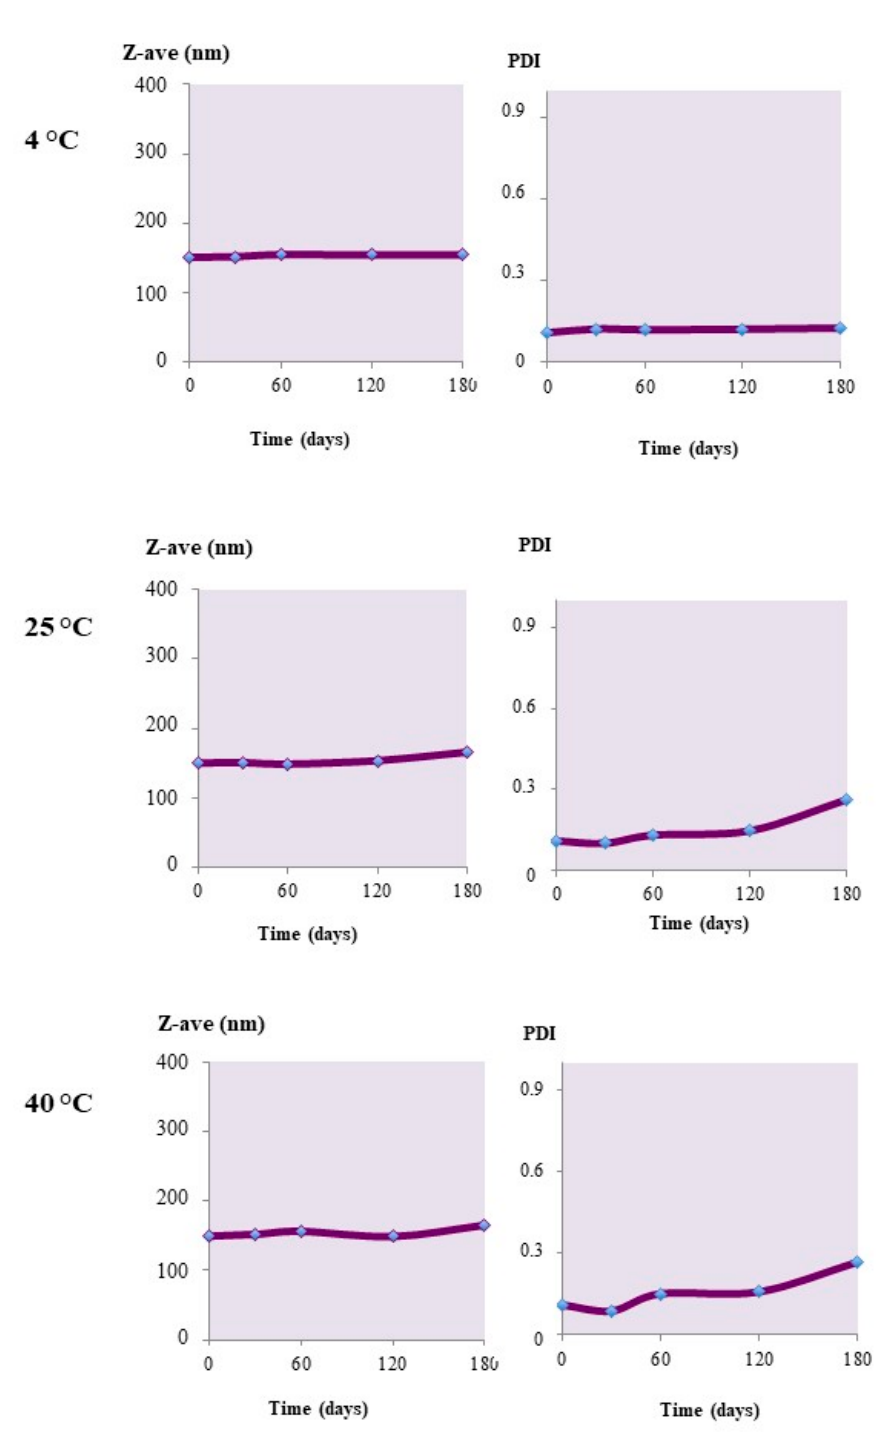
Figure 6. Z-Ave and PdI changes of Nile red-loaded Uns-PHA nanoparticles stored at different temperatures.